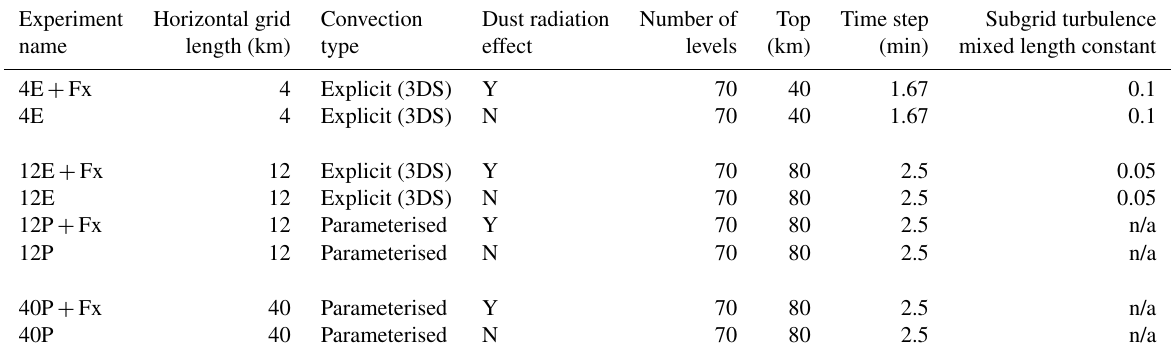
Table 1. Summary of model simulations run in SWAMMA. Experiment Horizontal grid Convection Dust radiation Number of Top Time step Subgrid turbulence name length (km) type effect levels (km) (min) mixed length